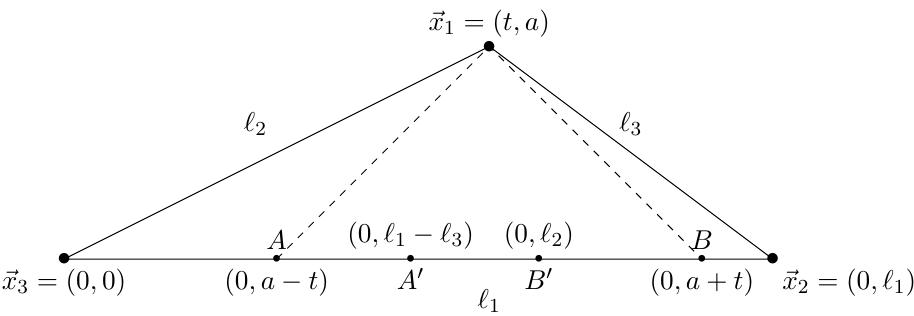
Figure 5. Time evolved operator (cid:30) 1 ( t; a ) = e (cid:0) iHt (cid:30) 1 (0 ; a ) e iHt at time t = 0 is con(cid:12)ned to the light-cone area inside the AB